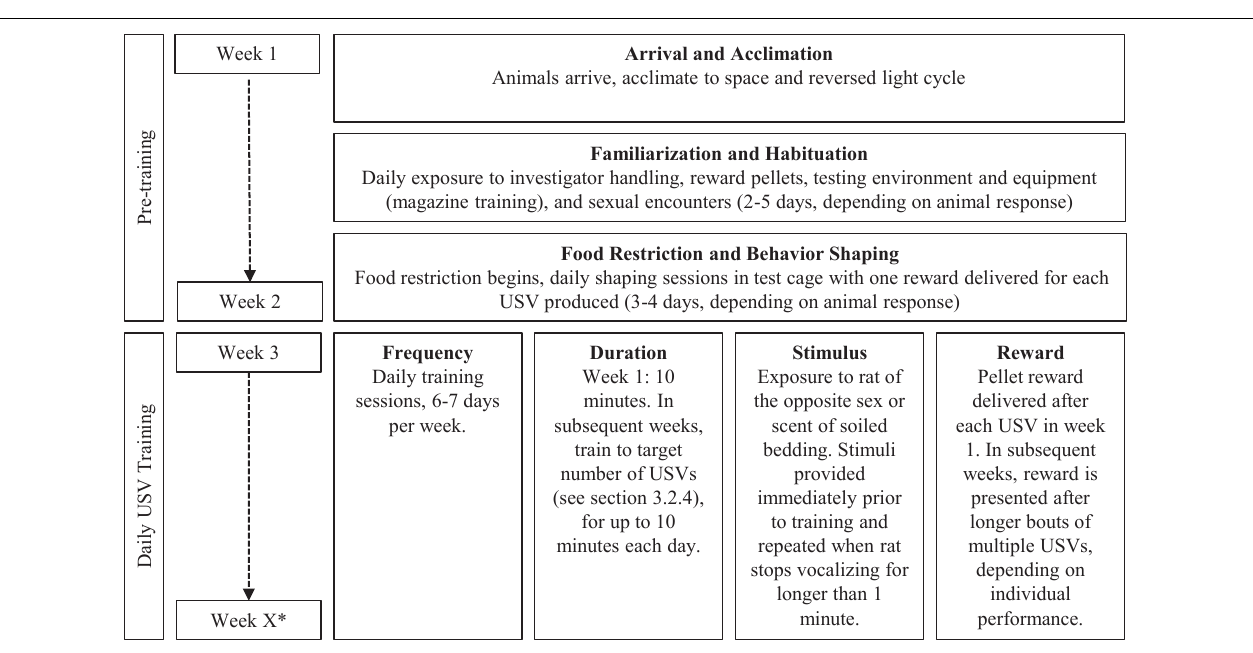
FIGURE 3 | Overview of pre-training and behavioral training timeline. ∗ Total number of weeks of training is determined by the experimental